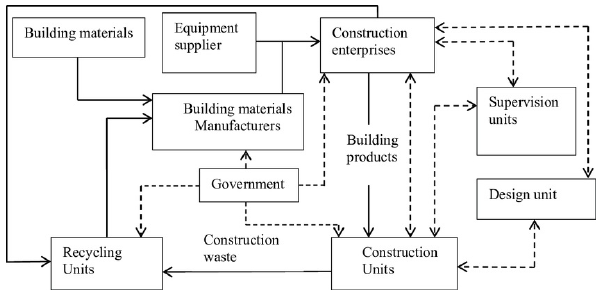
Fig. 1 The basic structure model of the supply chain.